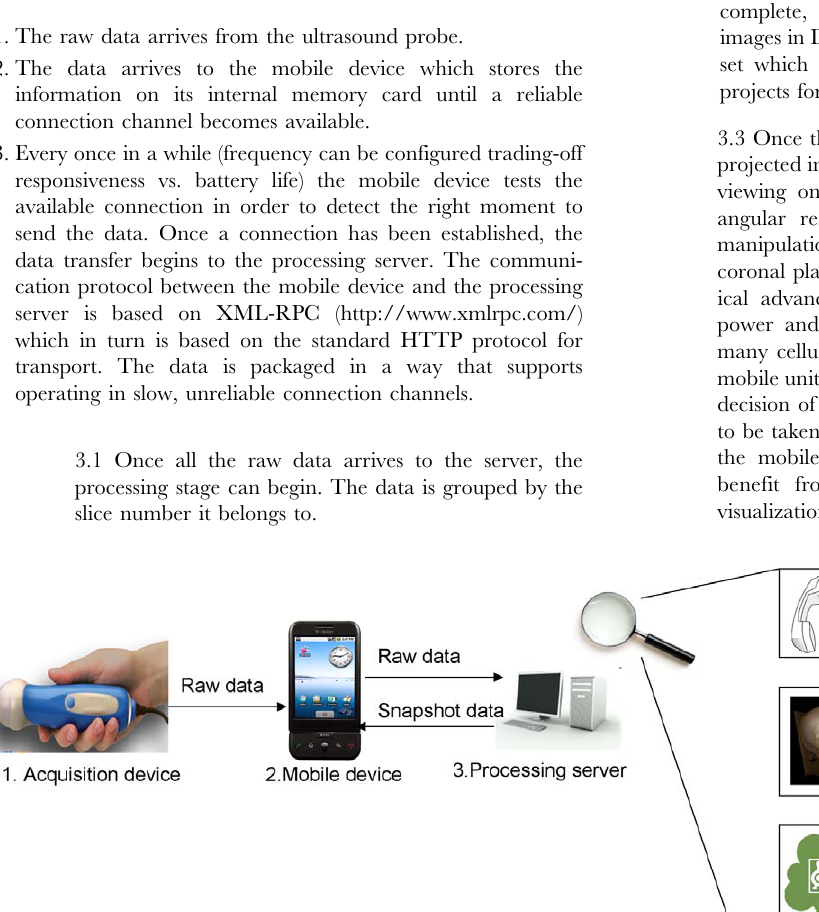
Figure 5. Integrated breast cancer self-examination device for home use.